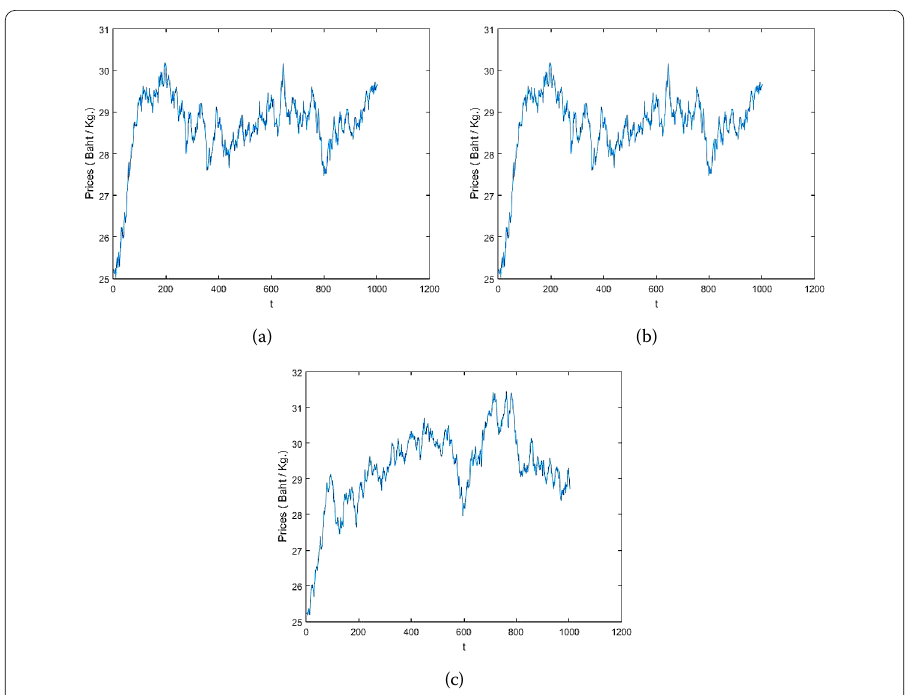
Figure 4 Results of simulation with Ornstein-Uhlenbeck process of BHMR: (a) Results of simulation with Ornstein-Uhlenbeck process of BHMR with least squares regression λ = 3.6724. (b) Results of simulation with Ornstein-Uhlenbeck process of BHMR with maximum likelihood estimation λ = 3.6724. (c) Results of simulation with Ornstein-Uhlenbeck process of BHMR with jackknife technique λ =